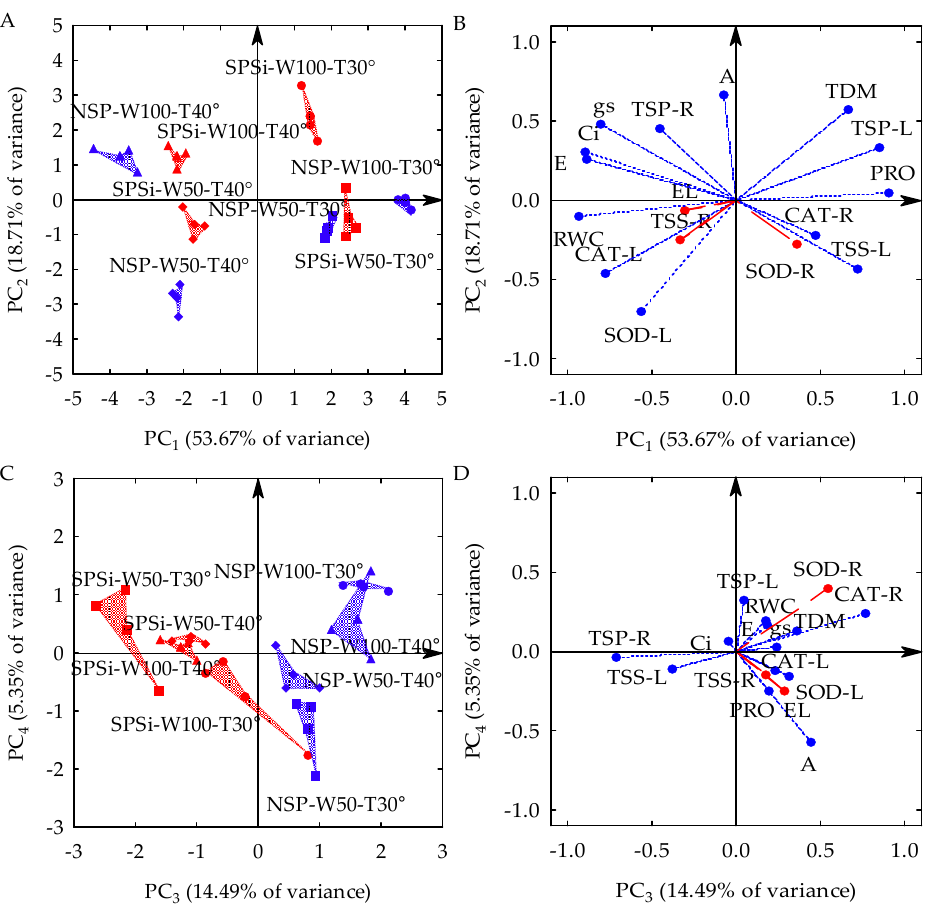
Figure 1. Two-dimensional projection of factorial scores ( A , C ) and variables ( B , D ) in the first four principal components (PCs 1, 2, 3, and 4) for the interaction between soil water replenishment levels (W50 and W100) and temperatures (T30° and T40°) in Moringa oleifera . PC, Principal Component; NSP, no seed priming; SPSi, seed priming with SiMPs; W100, no water stress; W50, water stress; T30°, no thermal stress; T40°, thermal stress; EL, electrolyte leakage; RWC, relative water content; TDM, total dry matter; A, net photosynthetic rate; gs, stomatal conductance; E, transpiration; Ci, internal CO 2 concentration; PRO, proline; TSP-L, total soluble proteins in leaves; TSP-R, total soluble proteins in roots; TSS-L, total soluble sugars in leaves; TSS-R, total soluble sugars in roots; SOD-L, superoxide dismutase in leaves; SOD-R, superoxide dismutase in roots; CAT-L, catalase in leaves; CAT-R, catalase in roots; ●, NSP-W100-T30°; ▲ , NSP-W100-T40°; ■ , NSP-W50-T30°; ♦ , NSP-W50-T40°; ●, SPSi-W100-T30°; ▲ , SPSi-W100-T40°; ■ , SPSi-W50-T30°; ♦ , SPSi-W50-T40°.